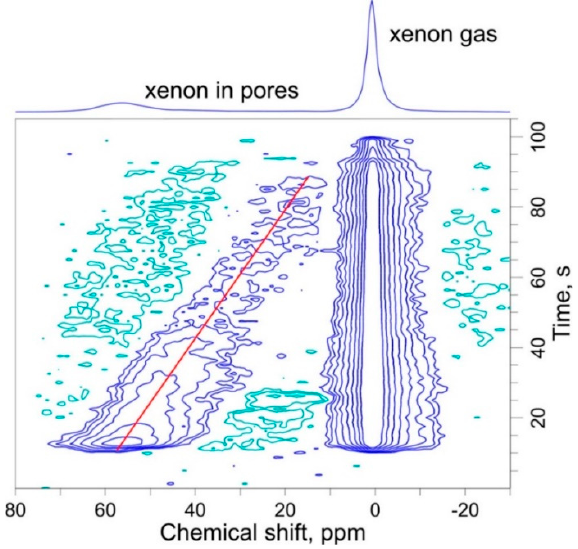
Figure 16. Time ‐ resolved HP 129 Xe NMR spectra of Pt/Al 2 O 3 pellets under the continuous flow of a propene:Xe:H 2 mixture. Reprinted with permission from reference [156]. Copyright 2020 American Chemical Society.